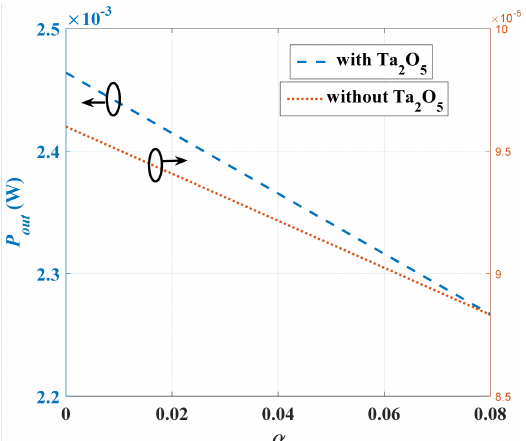
Figure 5. P out versus α at two different cases (with and without the deposition of Ta 2 O 5 ).